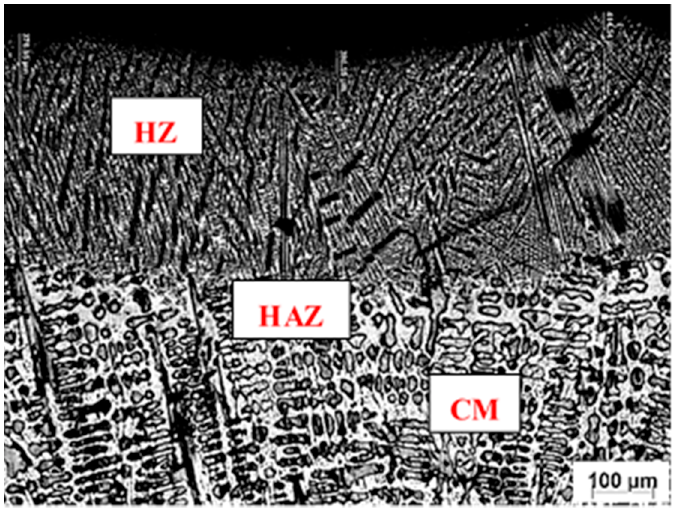
Figure 4. Optical image of the entire laser-treated area of LHT S1-1–4 sample; hardened zone (HZ), heat affected zone (HAZ) and cast metal (CM).